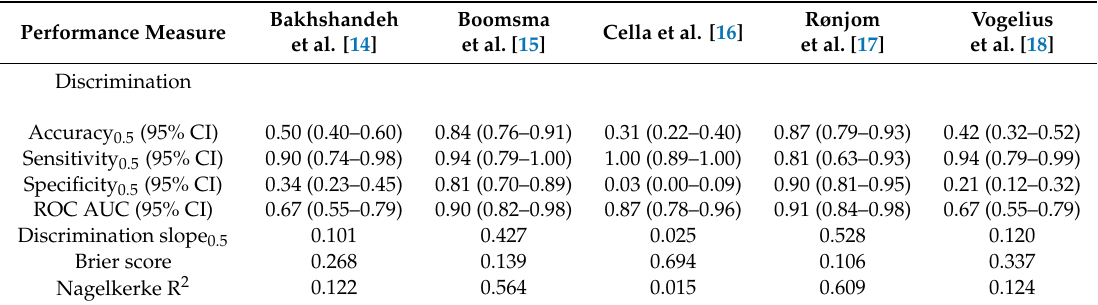
Table 2. Performance of the original NTCP models from the literature on the whole group of patients. Accuracy, sensitivity, specificity and discrimination slope were calculated for threshold value p = 0.5.